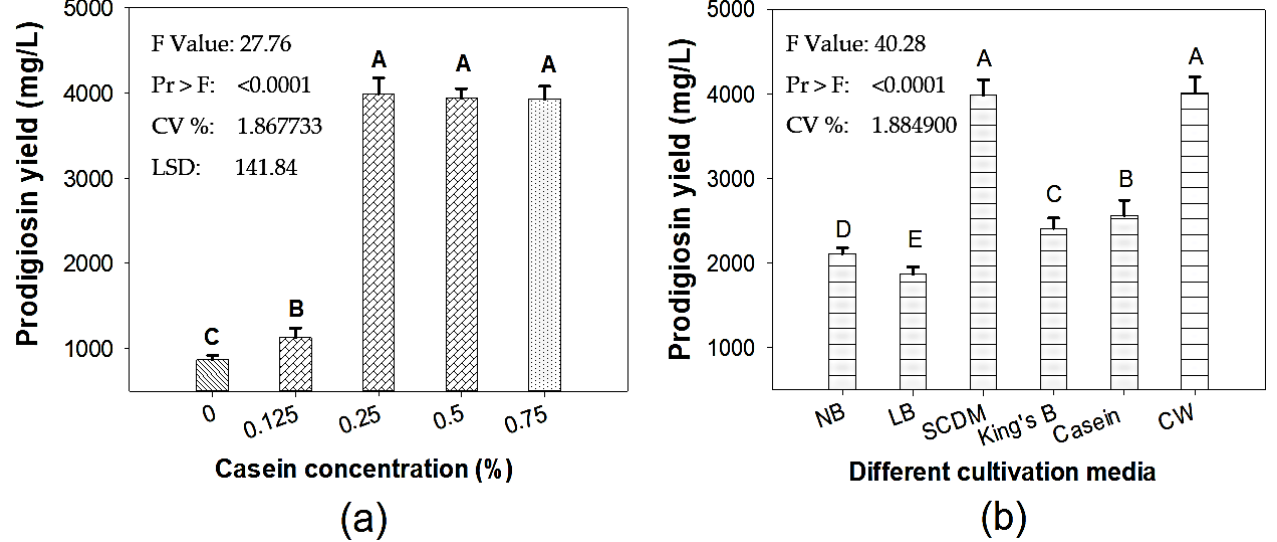
Figure 1. The effects of free protein added to the culture medium ( a ), and the effects of different cultivation media ( b ) on PG production with S . marcescens TNU01 fermentation. Standard errors (SD) are shown as error bars . The data were analyzed via the simple variance (ANOVA), then Fisher’s LSD test ( a ), and Duncan′s multiple range test ( b ) were evaluated at p = 0.01. Means of prodigiosin yield values with the same letter in each figure are not significantly different.